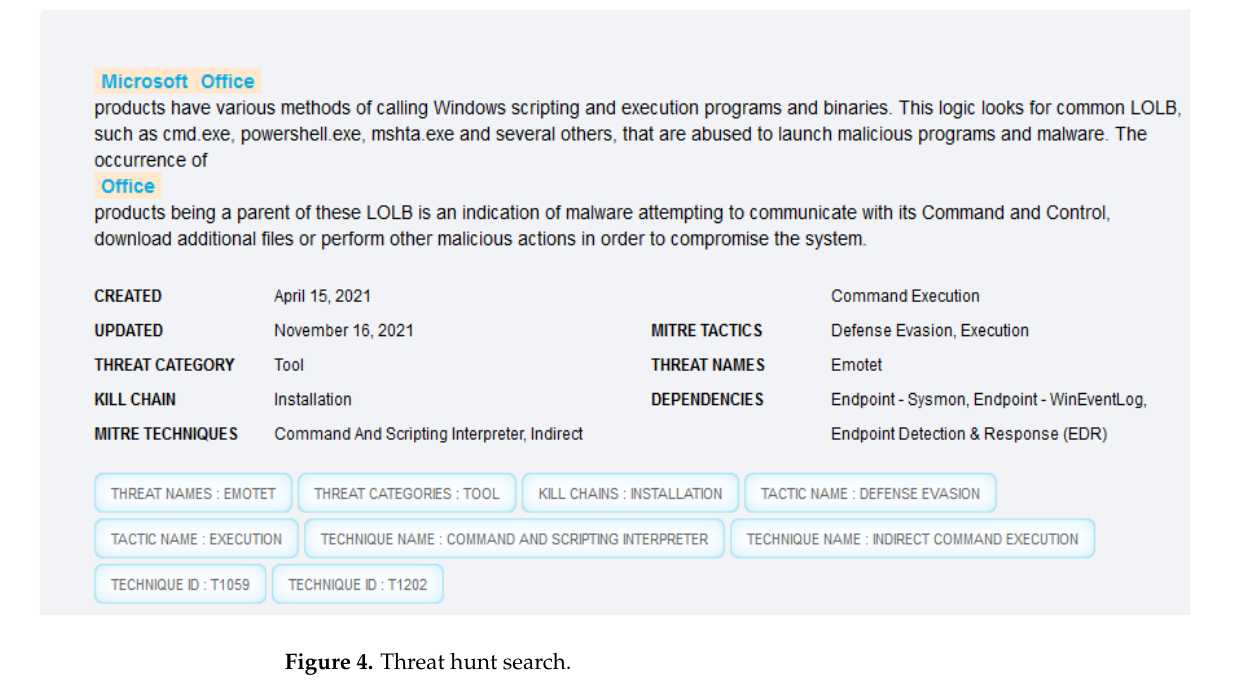
Figure 4. Threat hunt search.